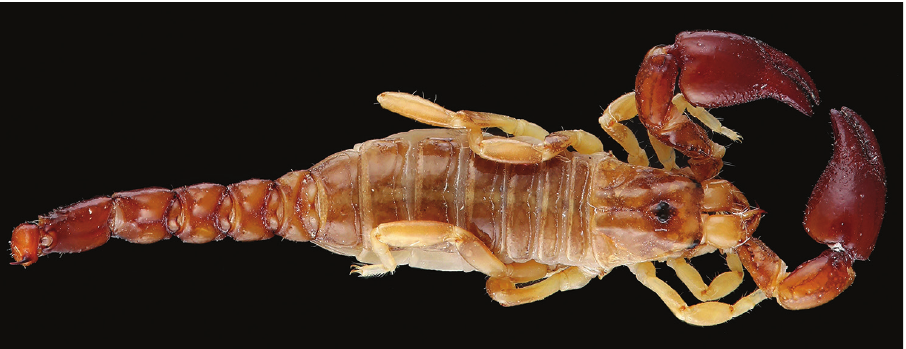
Figure 21. Auyantepuia sissomi , female holotype from upper Oyapock (photograph MNHN / E.-A. Diagnosis. Total length 26.2 mm for female holotype. General coloration yellow- ish. Carapace yellowish with light brown spots around the ocular tubercle and on the lateral edges of the carapace; posterior part and furrows lighter; ocular tubercle dark, almost black. Tergites greyish with several confluent lighter spots, yellowish, forming a longitudinal stripe. Venter yellow ochre. All metasomal segments reddish yellow, with greyish spots on lateral sides of I to V and on ventral side of III to V; ventral side of segments I and II without pigmentation. Vesicle reddish yellow; basis of aculeus red- dish and tip of aculeus reddish black. Chelicerae yellowish with greyish spots; fingers